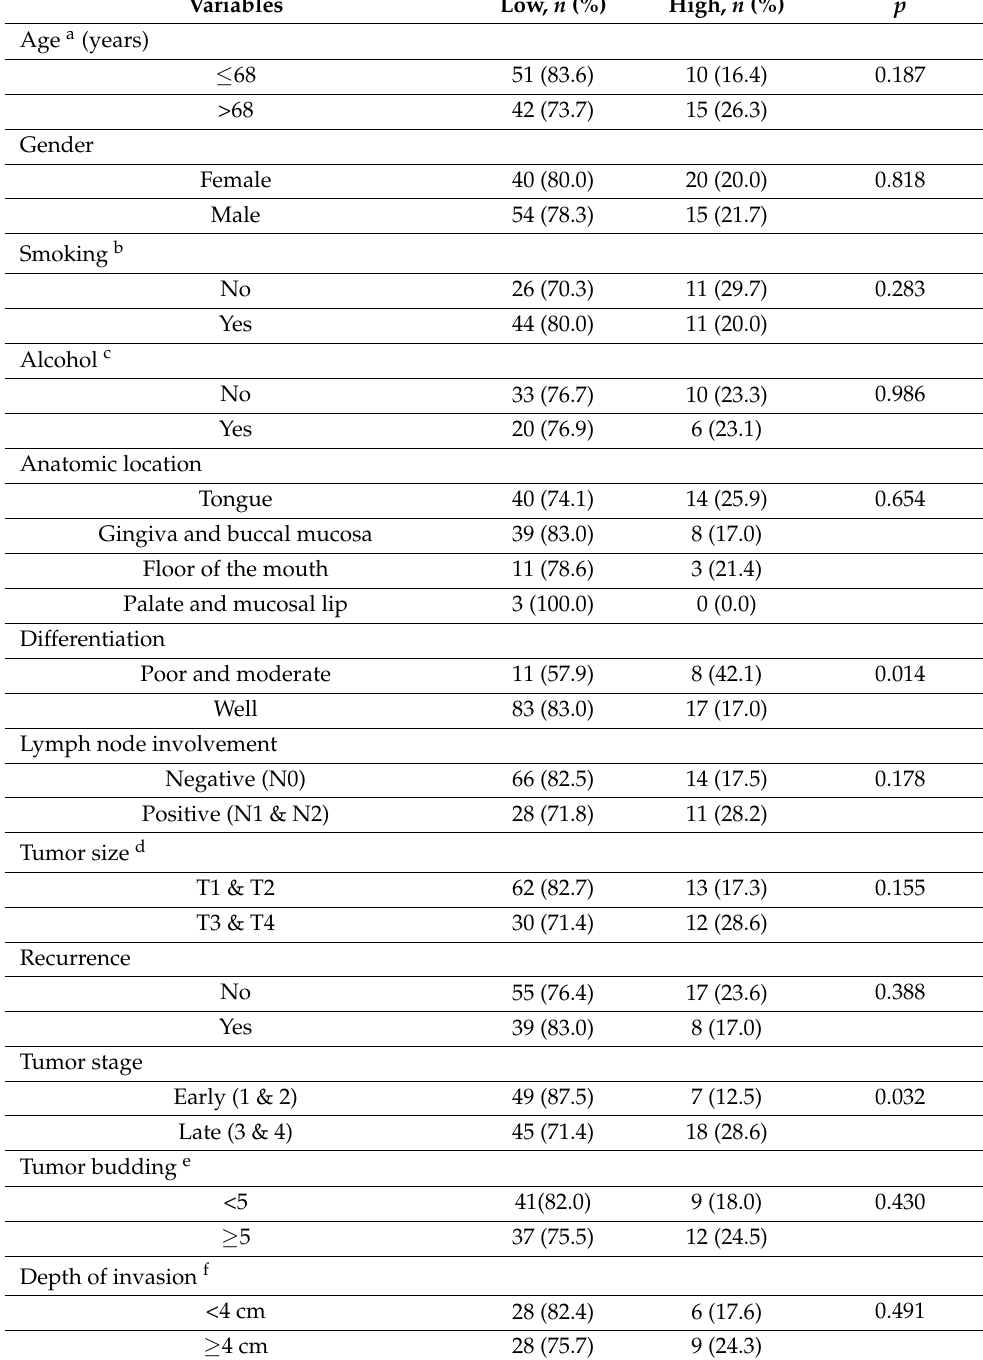
Table 1. HPA008999 immunoreactivity scores at tumor center and clinicopathological variables of the OSCC